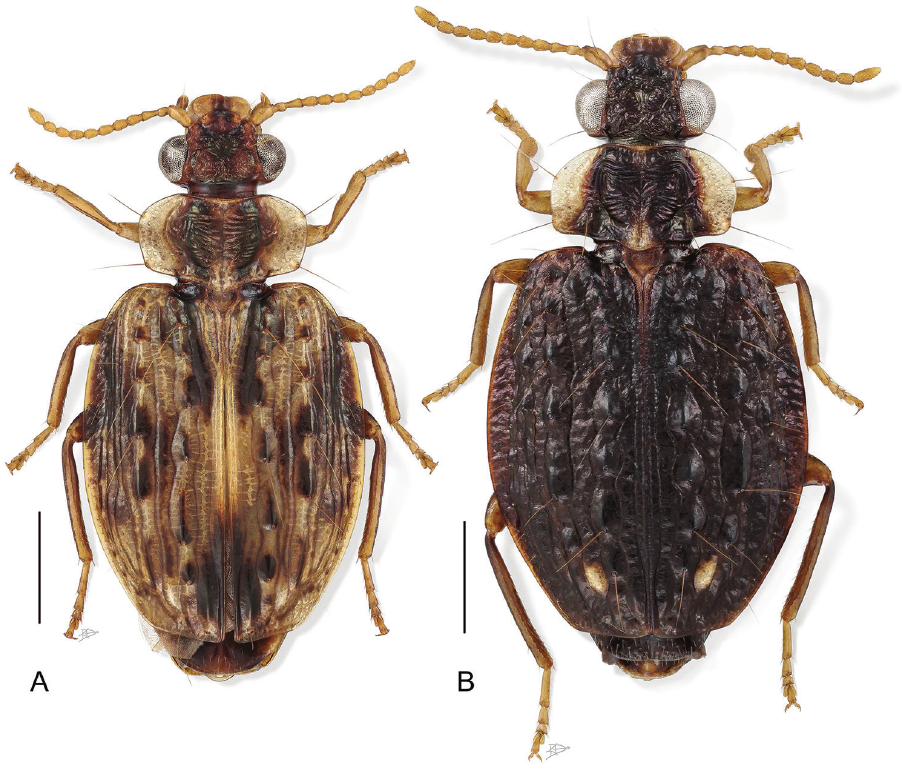
Figure 7. Digital Photo-illustration. Habitus, dorsal aspect. A Hyboptera dilutior Oberthür, male, ADP094021 B Hyboptera lucida Henry & Erwin, sp. n., female,